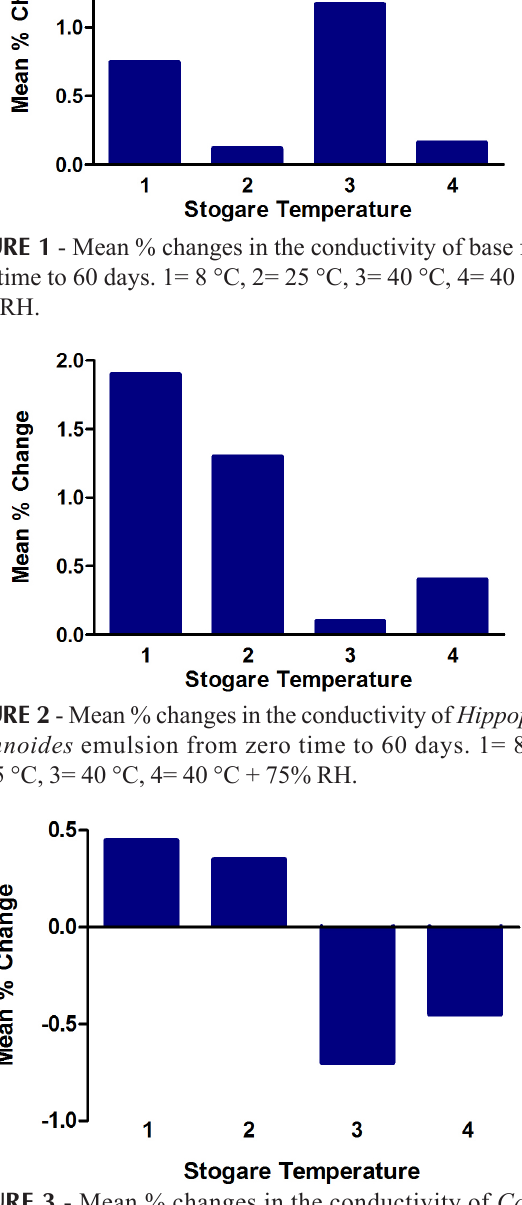
FIGURE 3 - Mean % changes in the conductivity of Cassia fistula emulsion from zero time to 60 days. 1= 8 °C, 2= 25 °C, 3= 40 °C, 4= 40 °C +75%